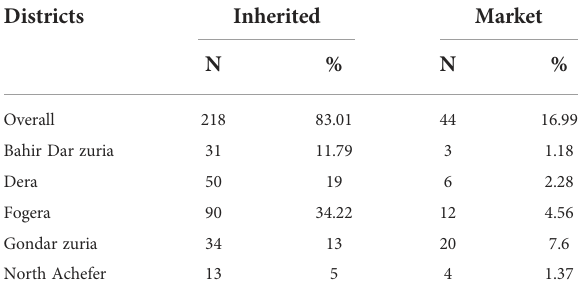
TABLE 10 Sources of the Fogera cattle